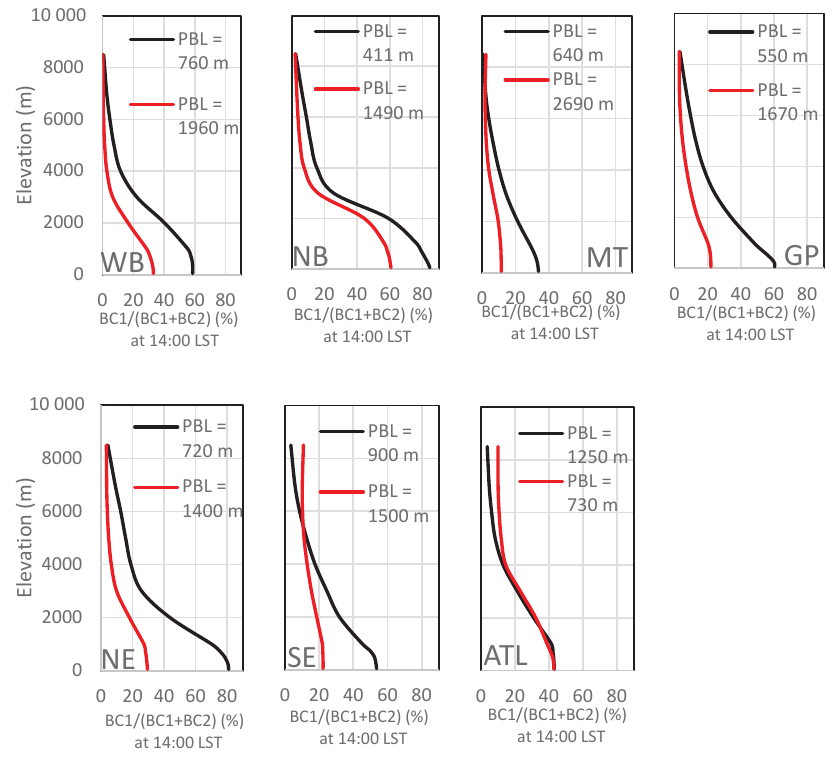
Figure 4. Seasonal averaged vertical profiles of BC1 /( BC1 + BC2 ) (in percentage) for WRF / CMAQ in winter (in black) and in summer (in red) over the subregions at their local standard time of 14:00. The numbers in the legend show the seasonal averaged maximum PBL height during the daytime over each